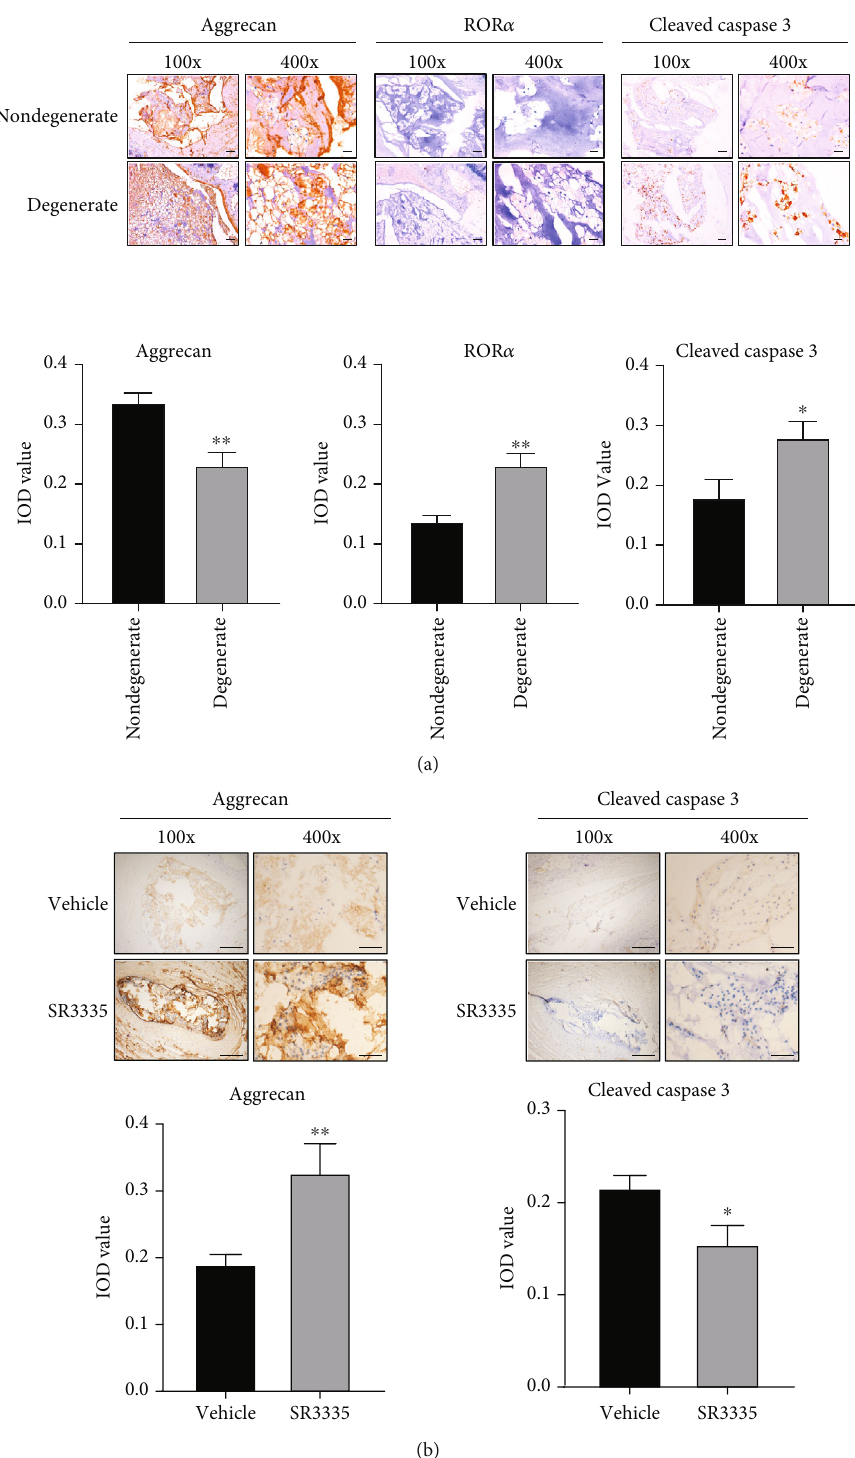
Figure 3: E ff ect of SR3335 on IDD model rat. (a) The expression of aggrecan, ROR α , and cleaved caspase 3 in nucleus pulposus tissue of needle puncture-induced IDD rat model or normal control shown by immunohistochemistry staining. The IOD value for the IHC picture is shown. Scale bar = 200 μ m for the 100x image, 50 μ m for the 400x image. N = 3 . (b) The expression of aggrecan and cleaved caspase 3 in nucleus pulposus tissue of needle puncture-induced IDD rat model after SR3335 or vehicle treatment for 4 weeks. The IOD value for the IHC picture is shown. Scale bar = 200 μ m for the 100x image, 50 μ m for the 400x